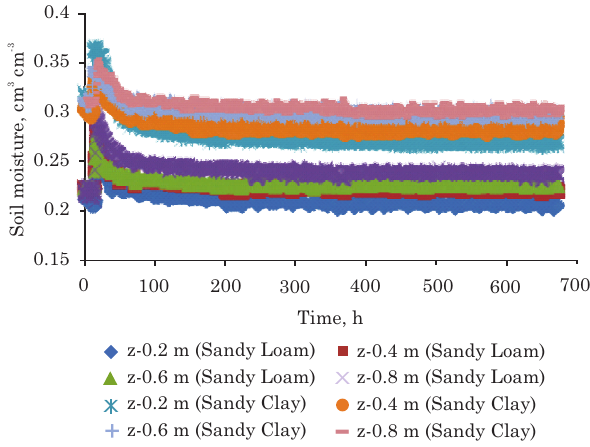
Figure 3. Moisture distribution in the plot during the experimental Table 2. Descriptive statistics for soil moisture (cm 3 cm -3 ) at the 16 monitoring points in four periods during the redistribution of water in soil